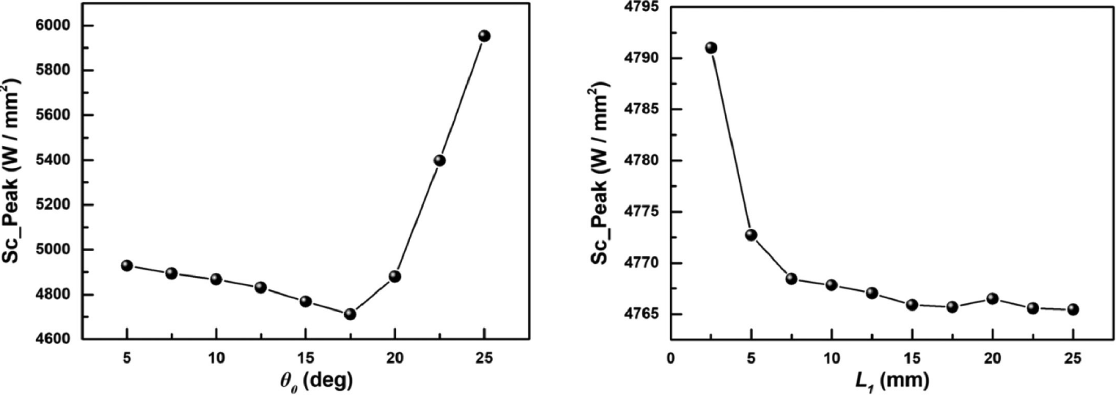
FIG. 4. Influences of θ 0 and L 1 on Sc_peak.